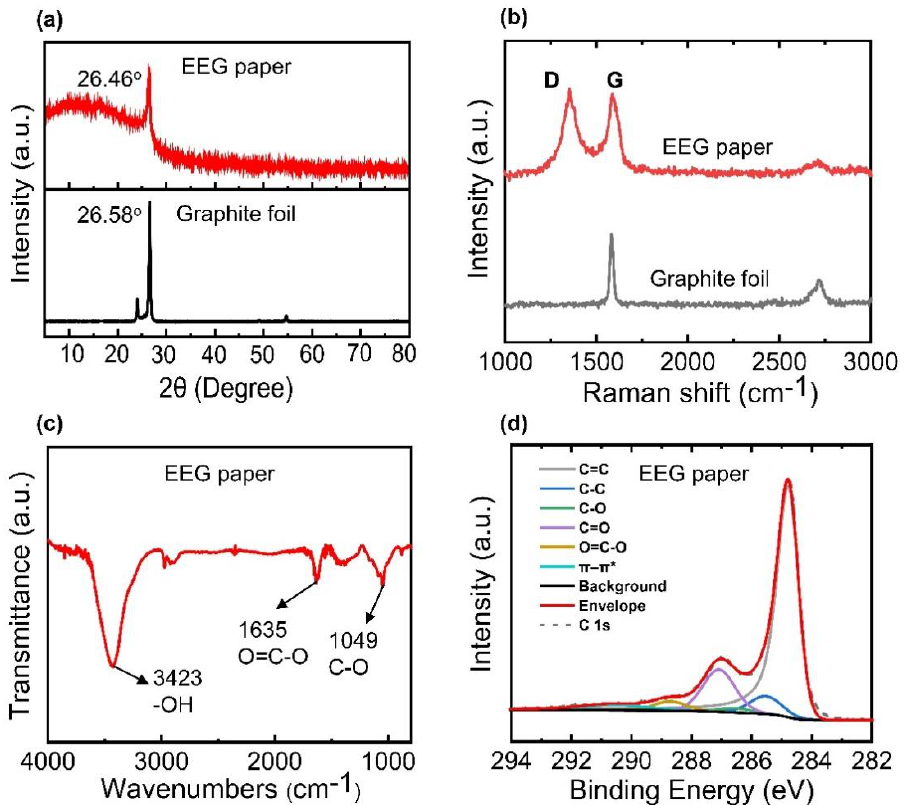
Figure 2. ( a ) XRD patterns and ( b ) Raman spectra of a graphite foil and the EEG paper; ( c ) FTIR spectrum and ( d ) XPS C 1s core-level spectrum of the EEG paper.